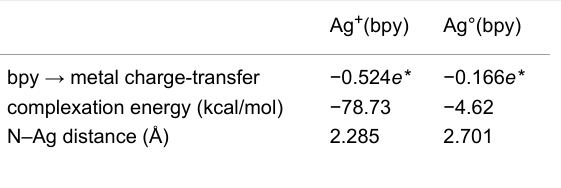
Table 2: Calculated bpy → metal electronic charge-transfers, N–Ag distances in Ag + (bpy) and Ag 0 (bpy) complexes and relative complex- ation energies. e * = proton